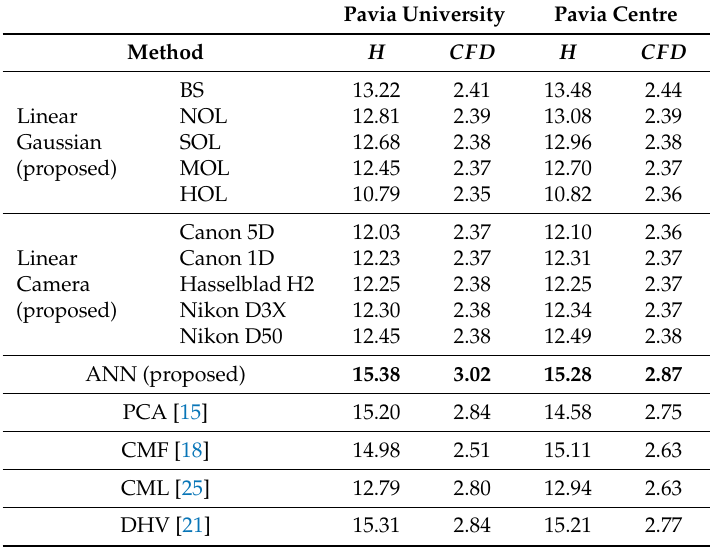
Table 1. Entropy and fractal dimension for the visualization results in Figures 9 and 10. The values in bold represent the highest values for the respective image.